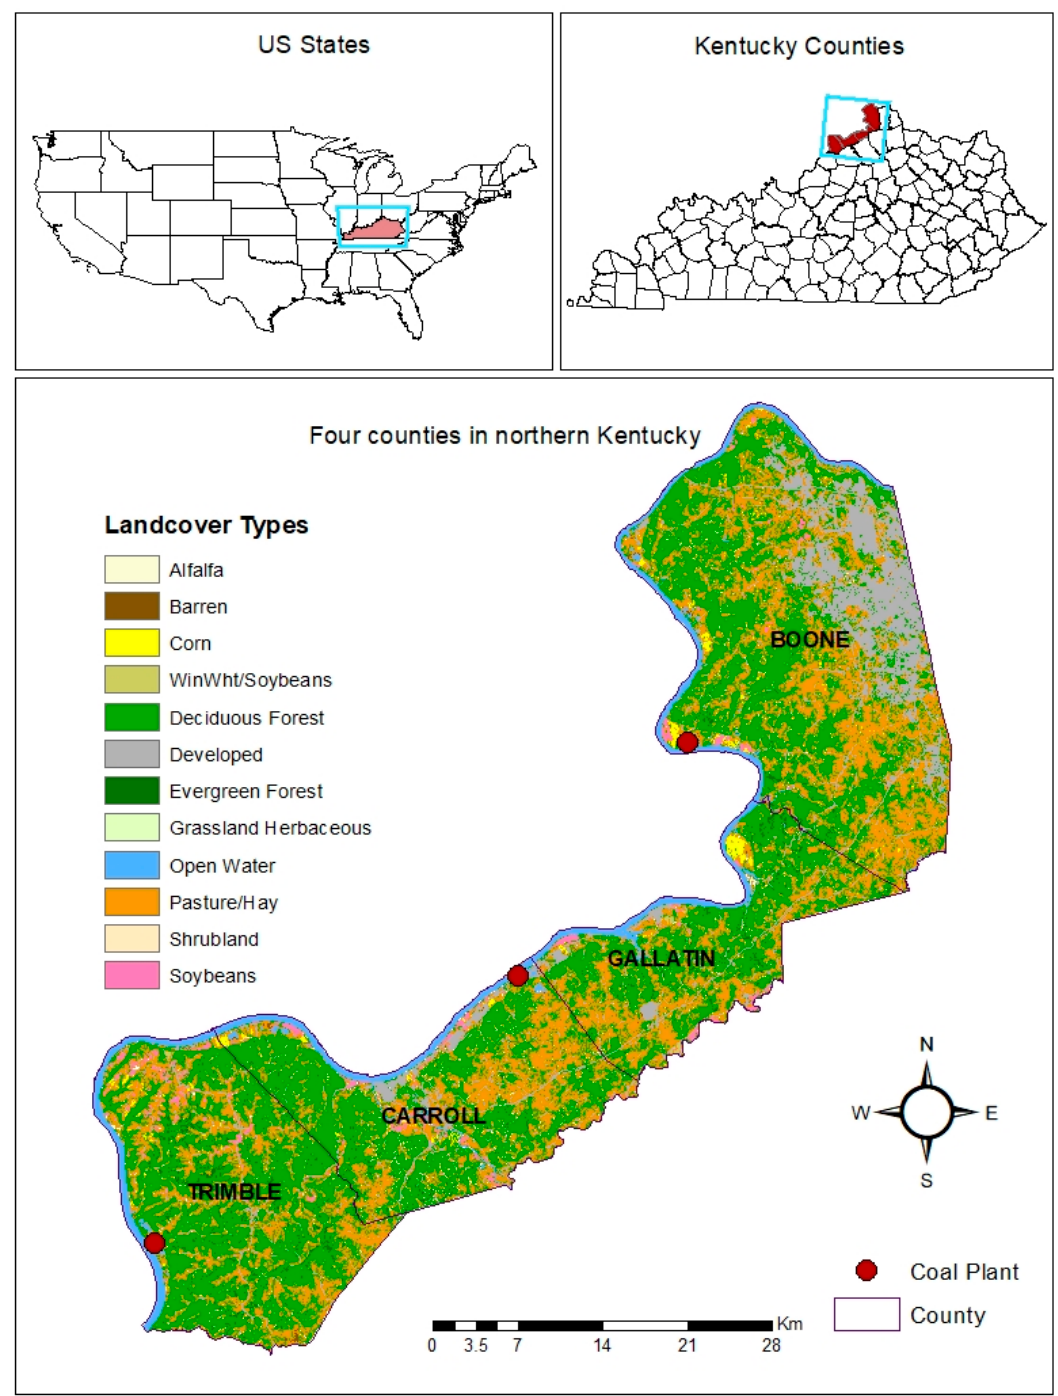
Figure 1. Four-county study area with different land cover types.